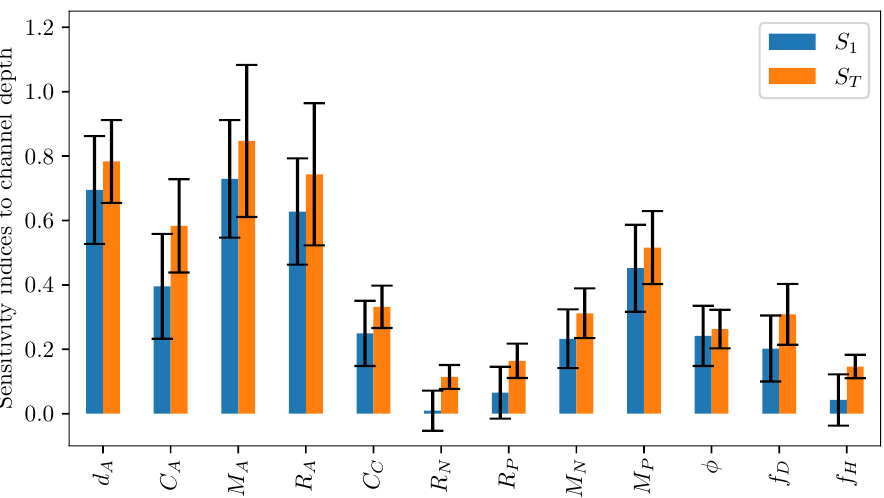
Figure 19. First order ( S 1 ) and total sensitivity ( S T ) indices of different lumped element parameters to channel depth. The error bar indicates 95% confidence interval.